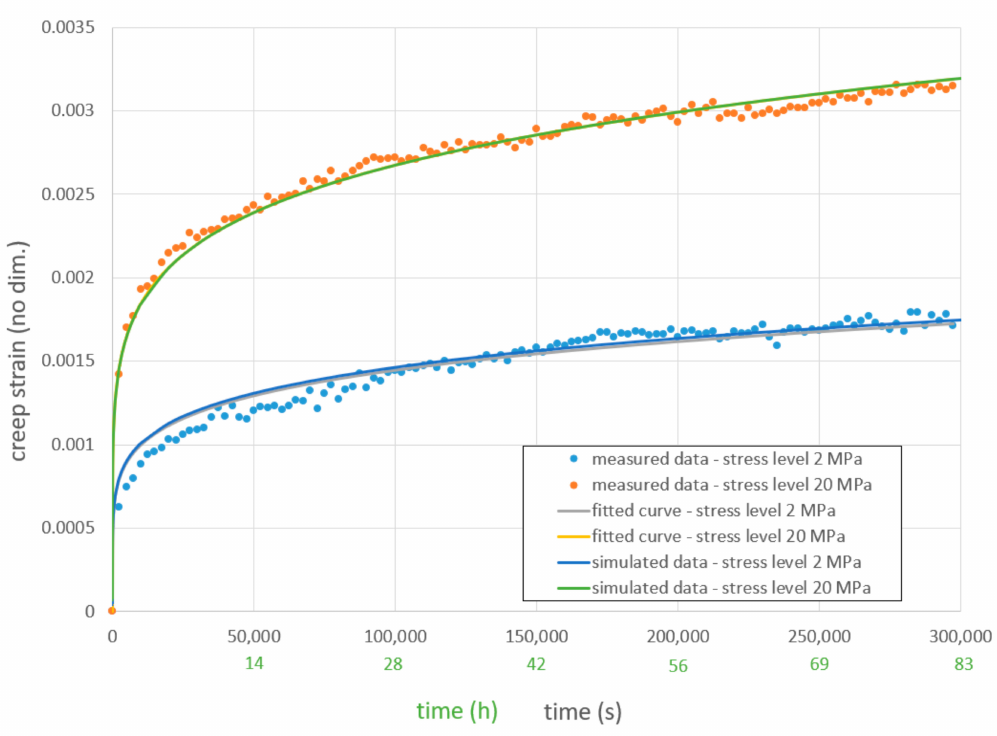
Figure 5. Measured, simulated (Section 4.1) and curve fitted creep strain–time graphs at di ff erent stress levels in z direction for “Polynt SMCarbon 80 CF60-3K / 2” at 120 ◦